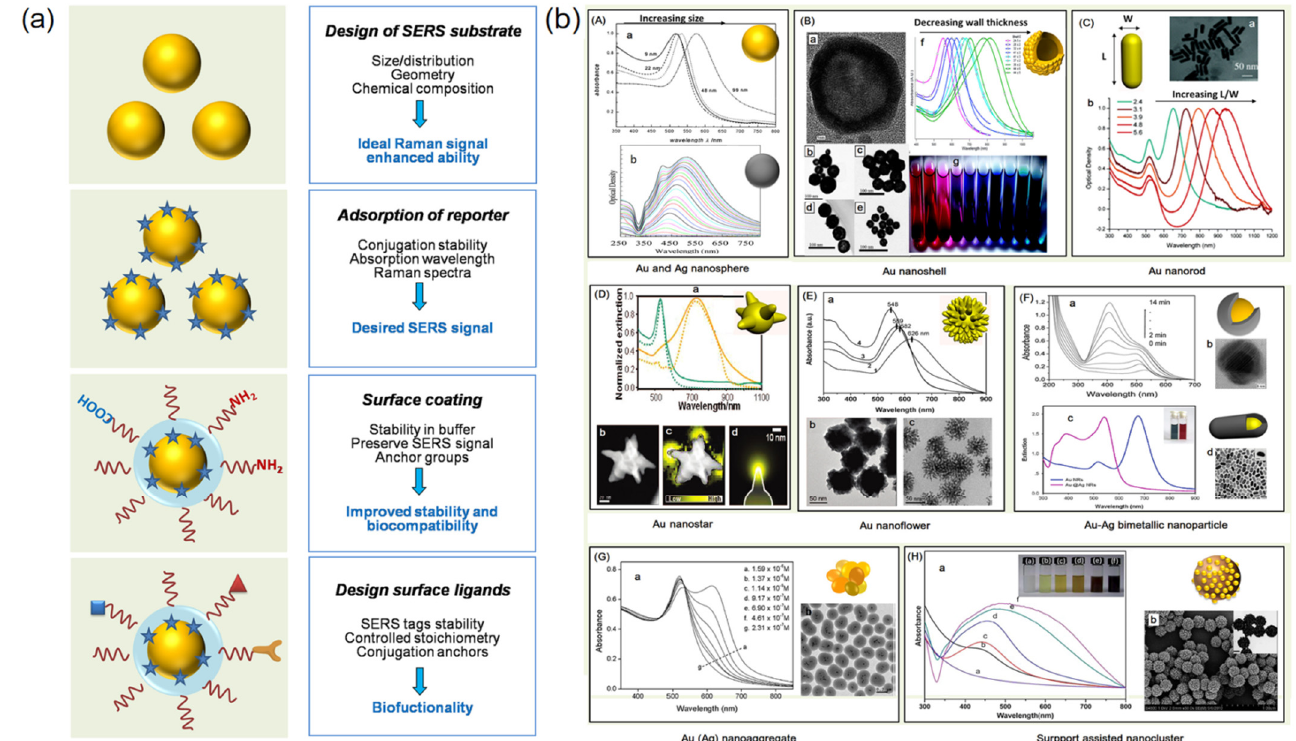
Figure 4. ( a ) Design of SERS tags for biochemical detection. ( b ) Representative nanosubstrates for SERS tags were synthesized. ( a , b ) Reproduced with permission of Ref. [39] , Copyright 2013, published by American Chemical Society.